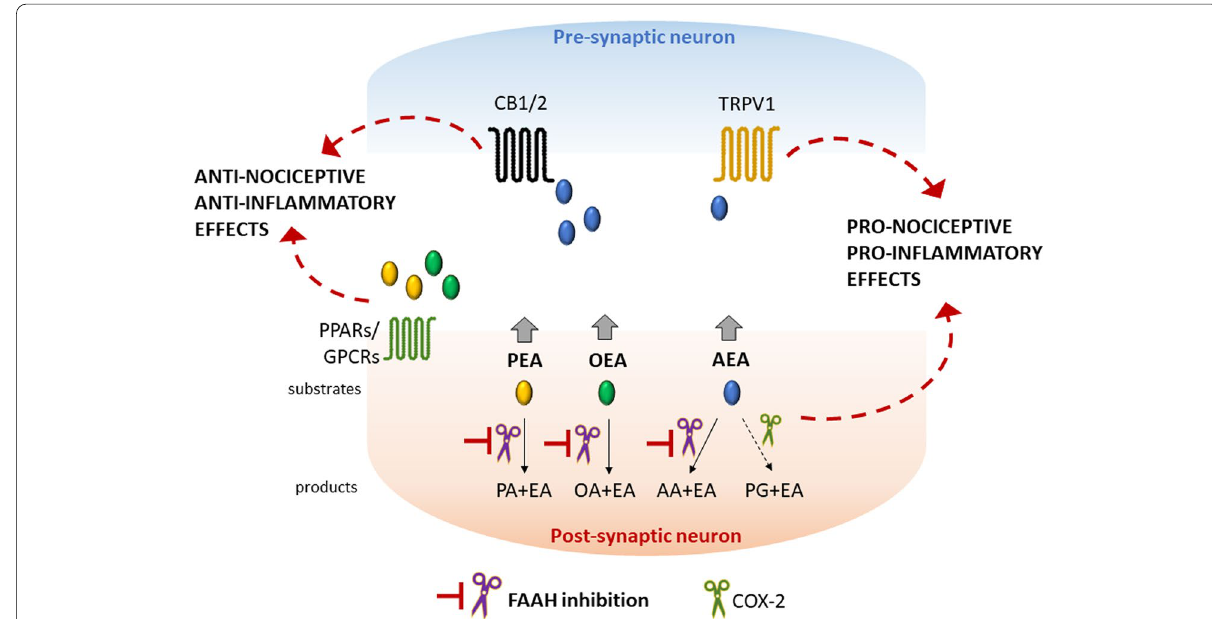
Fig. 7 Substrates and products of FAAH with their putative biological functions. The substrates of FAAH enzyme are bioactive amides like AEA, PEA and OEA; for example, AEA is hydrolyzed by FAAH into AA and EA. Inhibition of FAAH leads to an increase of these amides, whose function is to promote anti-nociceptive and anti-inflammatory effects through the activation of CB1/2, PPARs and GPCRs receptors. It must be however noted that, in certain circumstances, AEA can also act on TRPV1 channels causing pro-nociceptive effects. In addition, a small amount of AEA may be metabolized also by COX-2, leading to an increase in pro-inflammatory prostaglandins. For a more comprehensive and detailed description of the endocannabinoids and related lipids metabolism and biological functions, refer to [31, 32, 36]. AA arachidonic acid; = AEA anandamide; CB1/2 cannabinoid receptors 1 and 2; COX-2 cyclooxygenase-2; EA ethanolamine; FAAH fatty acid amide hydrolase; = = = = = Gly glycerol; GPCRs G-protein-coupled receptors; OA oleic acid; OEA oleoylethanolamide; PA palmitic acid; PEA palmitoylethanolamide; = = = = = = PG prostaglandin; PPARs peroxisome proliferator-activated receptors; TRPV1 transient receptor potential cation channel subfamily V member = = =